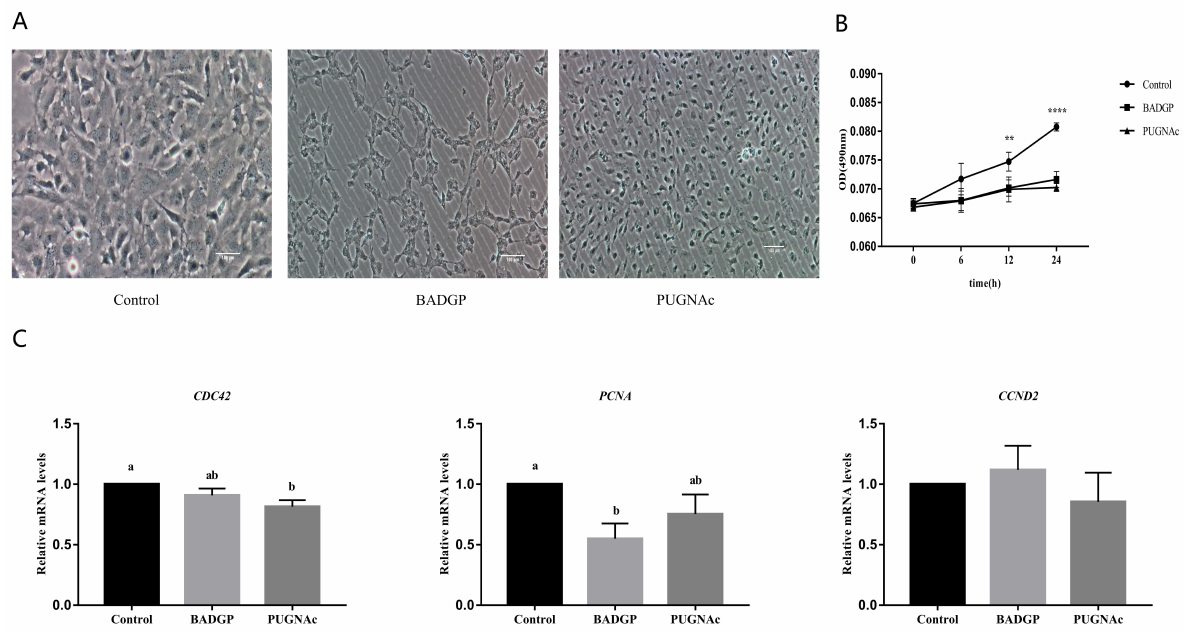
Figure 2. Disruption of O-GlcNAc cycling affects viability and proliferation of GCs. ( A ) Representa- tive photomicrographs of GCs. Bar = 100 µ m. ( B ) Effects of dysregulated O-GlcNAcylation on cell viability at different time points. Cell viability was tested in samples challenged with BADGP or PUGNAc at 6 h, 12 h, and 24 h, respectively. ( C ) Relative mRNA expression levels of proliferation- related genes CDC42 , PCNA , and CCND2 in GCs. Values are mean ± SEM of at least three replicates.